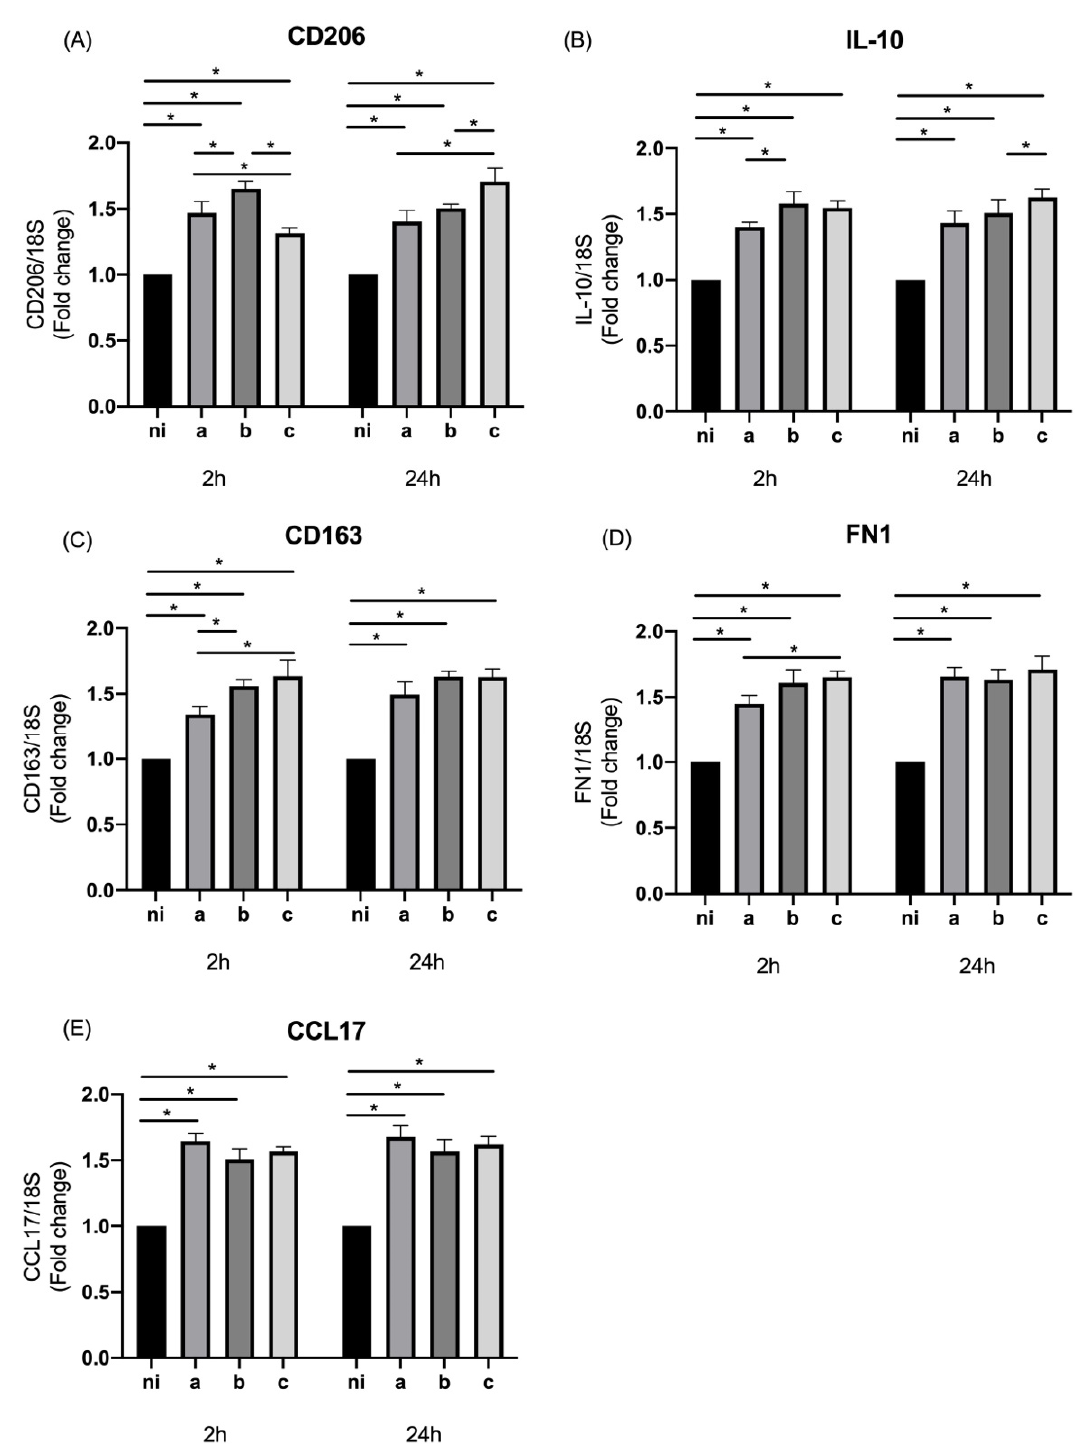
Figure 3. M2 markers’ expression by Aggregatibacter actinomycetemcomitans -induced THP-1 human macrophages (ATCC ® TIB-202TM). Expression in macrophages infected at an MOI = 102 with strains ATCC ® 43717TM (serotype a), ATCC ® 43718TM (serotype b), and ATCC ® 43719TM (serotype c), 2 and 24 h after infection. For relative expression, mRNA expression in non-infected (ni) macrophages was considered as 1, as a reference for fold-change in expression using 18S rRNA expression levels as a normalizing endogenous control. Data are represented as fold-change means and standard deviation of three independent experiments performed in duplicate. Asterisks were used to indicate a value of p considered statistically significant (* p < 0.05).